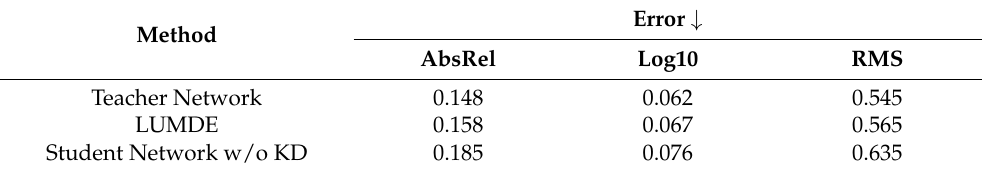
Table 5. Comparison between LUMDE and student network without